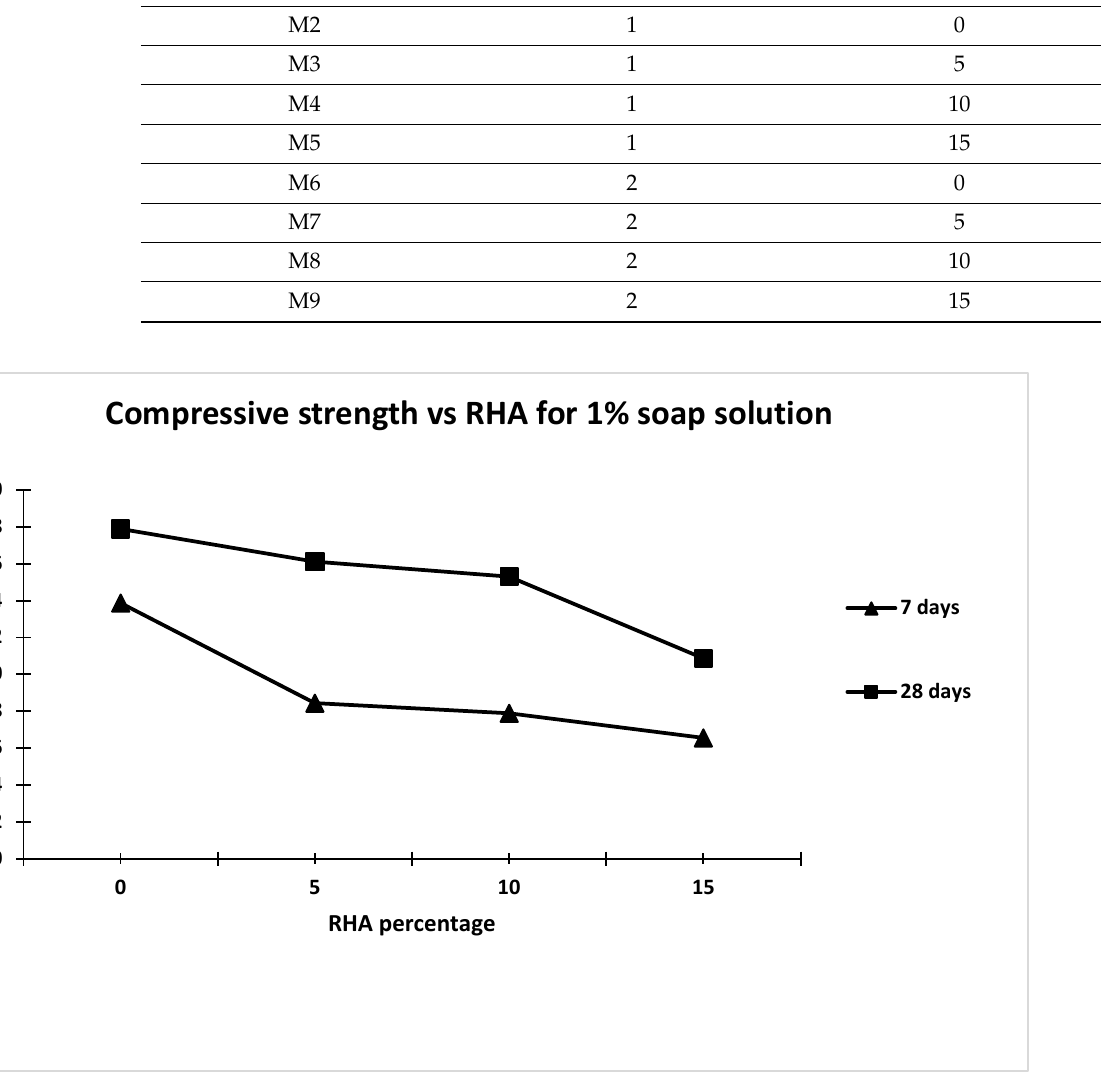
Table 3. Different composition of concrete mixes.